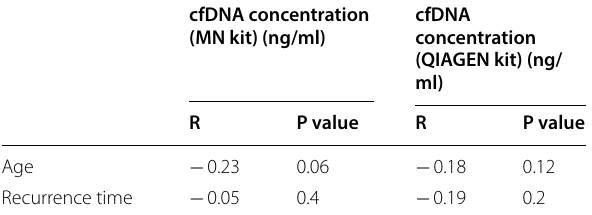
Table 3 Partial